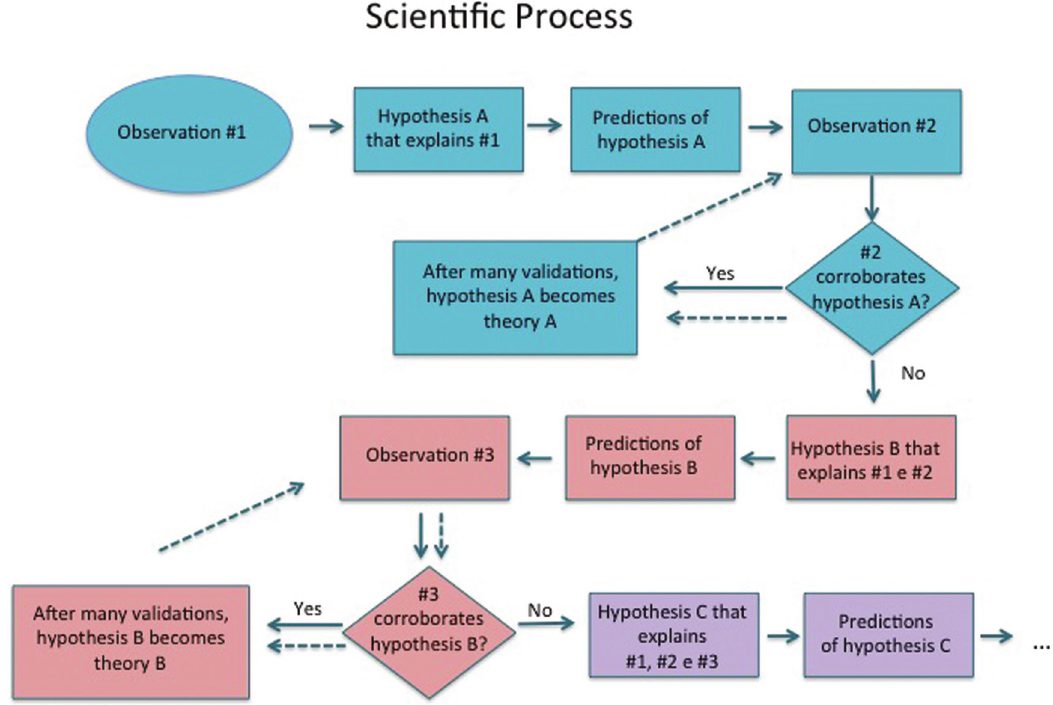
Figure 1 - The flow chart illustrates the difference between a scientific hypothesis and a scientific theory. A theory is the highest place an explanation for facts may reach in